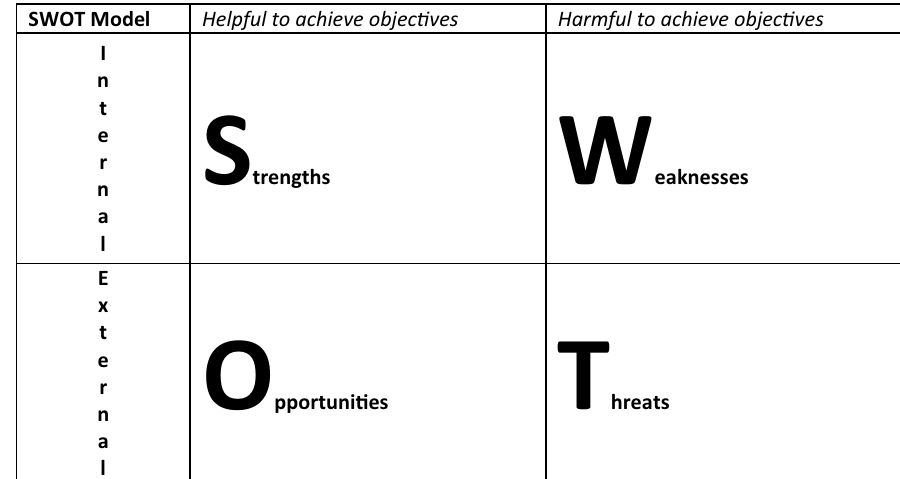
Fig. 1 The SWOT analysis framework